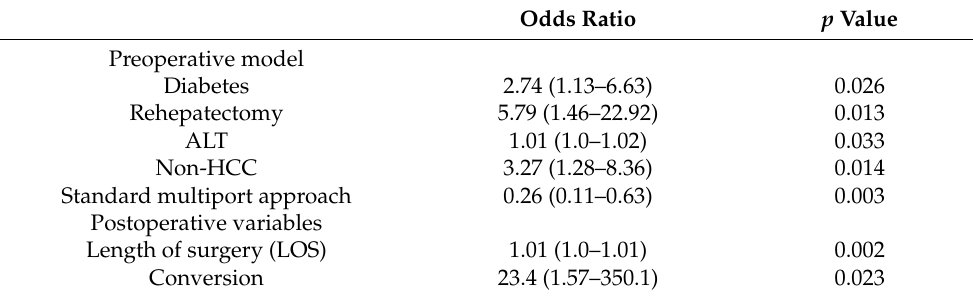
Table 3. Variables retained after the multivariate